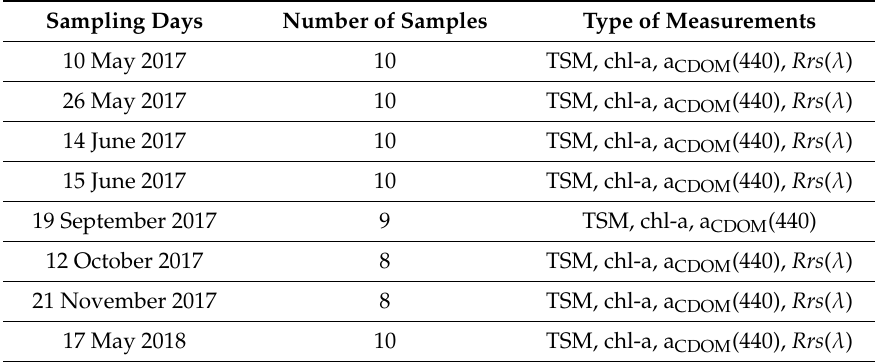
Table 1. Detailed information about the in situ measurement campaigns. The measurements were addressed to retrieve information on: total suspended matter—TSM, chlorophyll-a—chl-a,